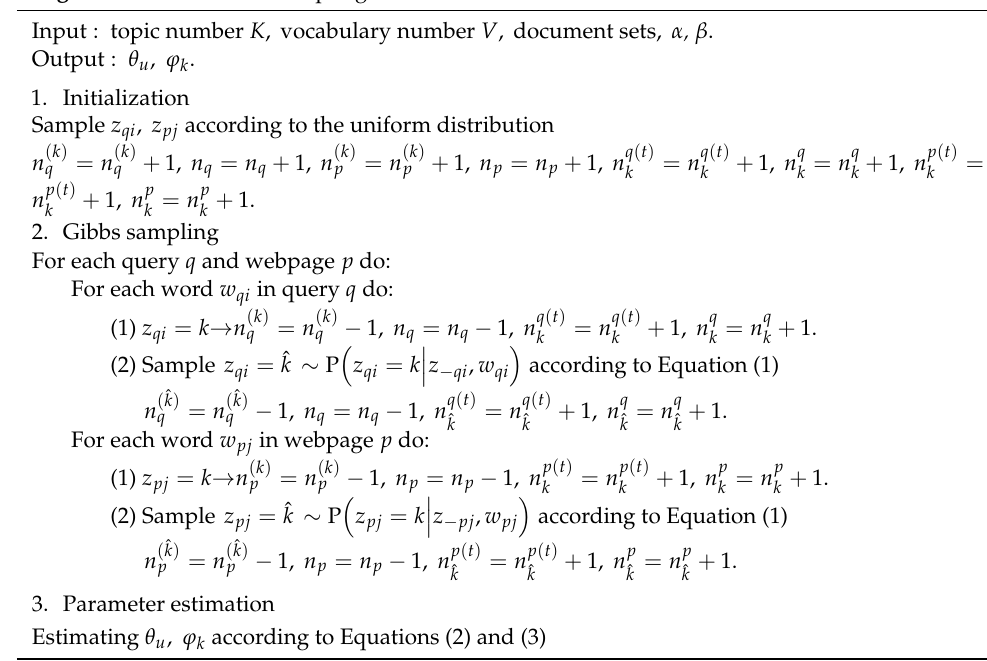
Algorithm 1: The Gibbs sampling for